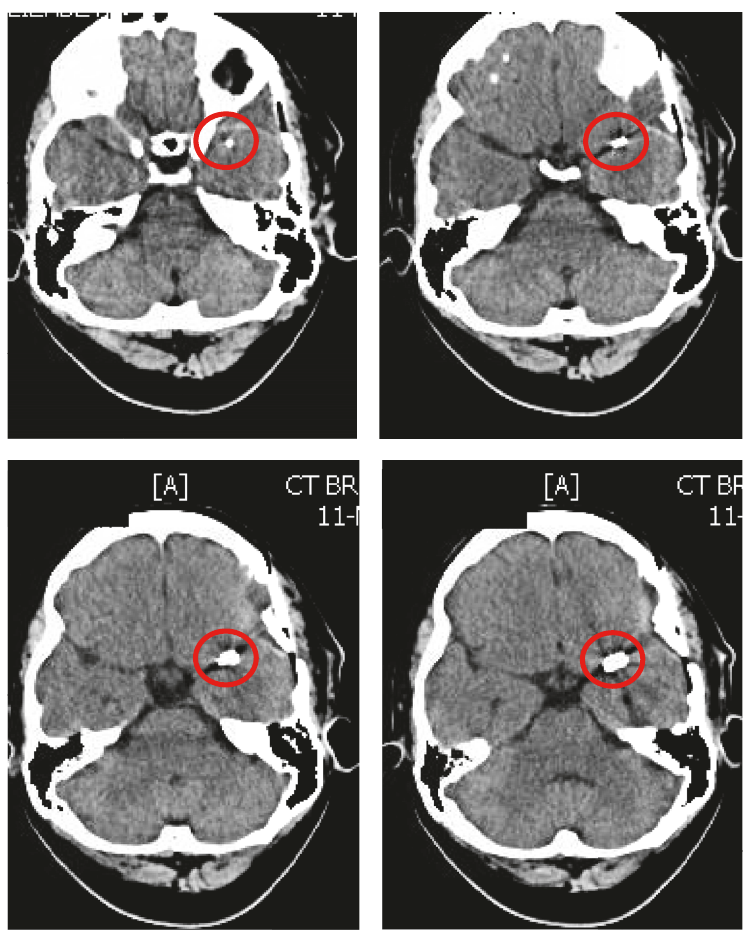
Figure 2: CT scan of brain without contrast axial view on November 11, 2016, after left temporal craniotomy and clipping of left MCA aneurysm: showing the clip in the area of the proximal left middle cerebral artery (red